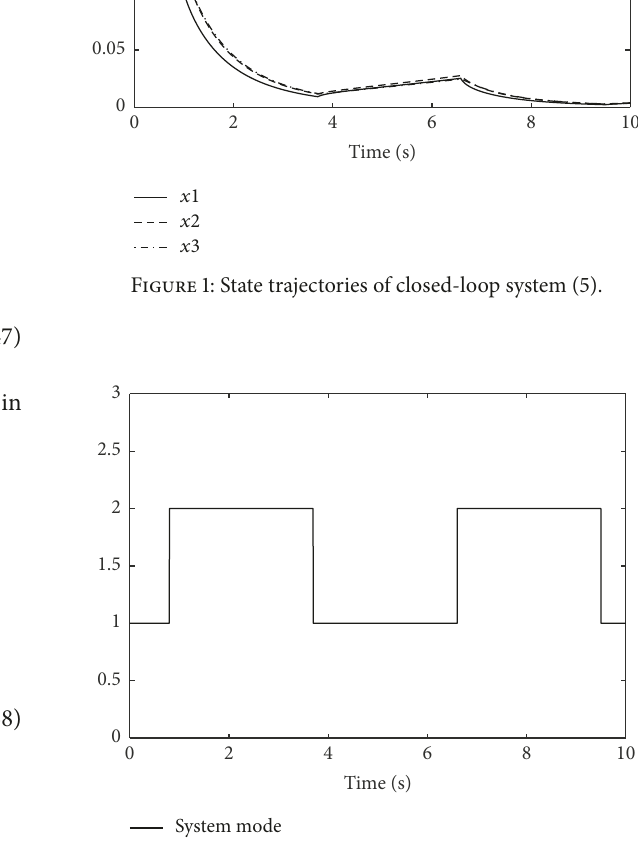
Figure 2: Switching signal of system (5) with ADT.